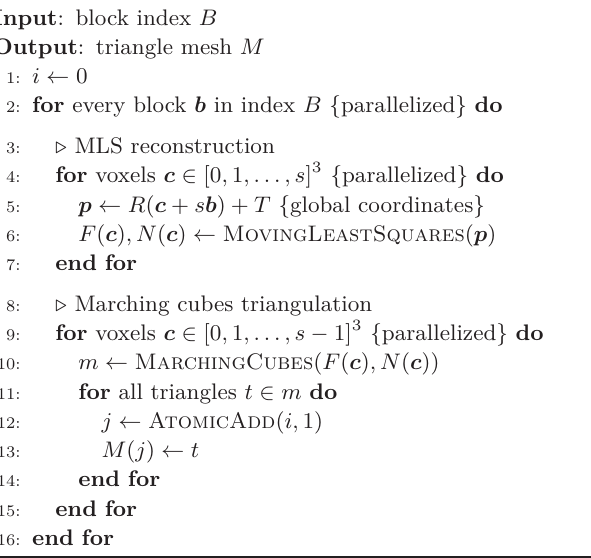
Algorithm 3 3D reconstruction and mesh